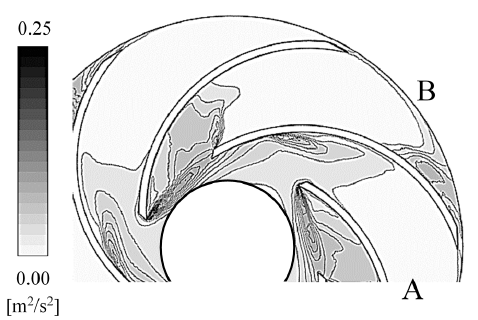
Figure 5. Contour of turbulence kinetic energy k 2 D on the spanwise 50% surface by CFD, the experimental pattern can be found in Reference [32].